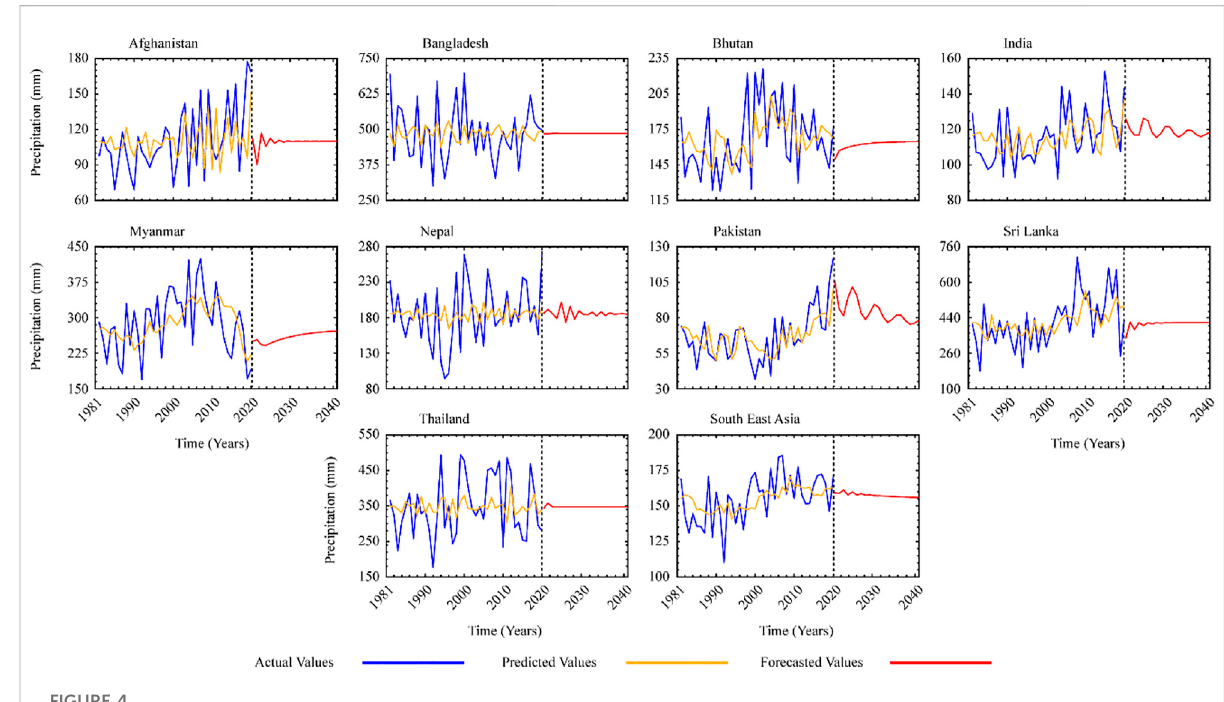
FIGURE 4 ARIMA Forecasting for time series spring mean precipitation for the study